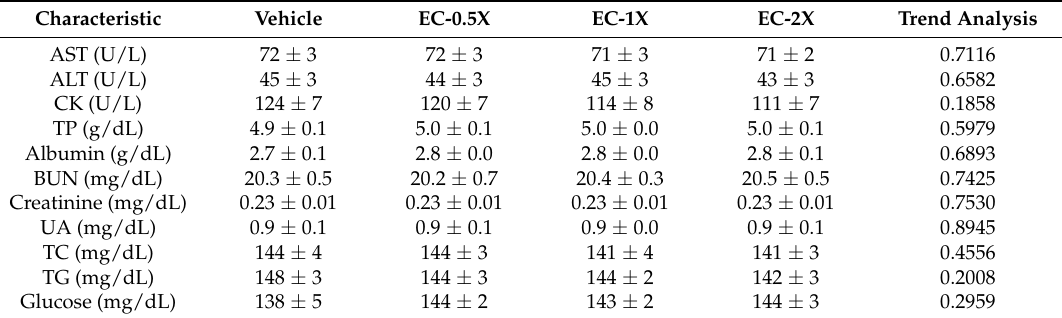
Table 5. Effect of EC on mice serum biochemical markers at